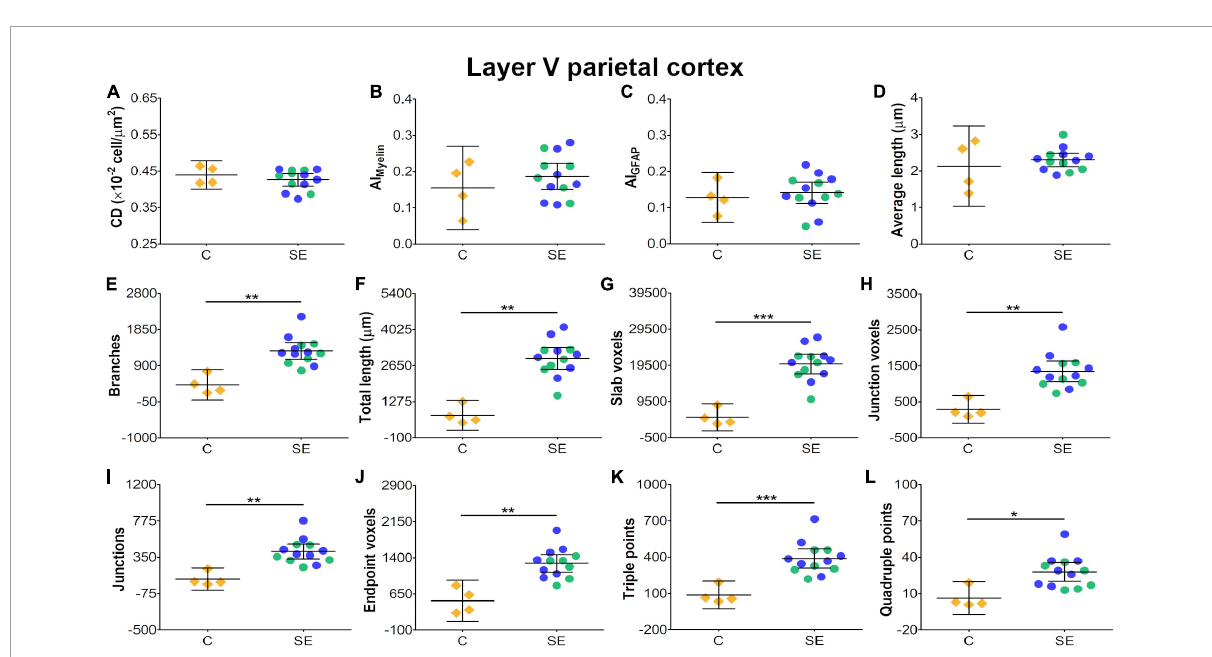
FIGURE5 Histological-derived parameters from automated cell counting analyses (A) , structure-tensor (ST)-based analyses of myelin (B) , and ST (C) and skeleton-based analysis (D–L) from GFAP-stained sections in layer V of the parietal cortex. Notations as in Figure 4 . SE animals revealed increases in all skeleton-based parameters (E–L) as compared to controls (BH-FDR-corrected q -values * < 0.05, ** < 0.01, *** < 0.001; two-side permutation t -test). AI, anisotropy index; C, control; CD, cell density; SE, status